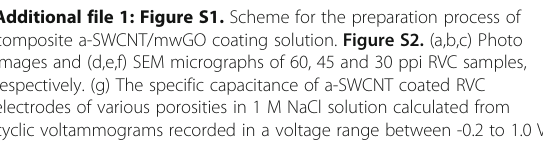
using a three-electrode system vs Ag/AgCl at 5mV/s scan rate. Figure S3. Schematic diagram of the preparation process of ratio 9:1 composite a- SWCNT/mwGO coated RVC electrode. Figure S4. (a and b) Energy- dispersive X-ray (EDX) spectra, (c) the XRD patterns of the graphite flakes powder and GO film respectively, and (d) Fourier-Transform Infrared (FT-IR) spectrum for graphene oxide film. Inset shows SEM and optical images of the (a) graphite flakes powder and (b) the GO film. Figure S5. (a and b) SEM images of GO and mwGO, respectively, (c) the XRD patterns of GO and mwGO and (d and e) Energy-dispersive X-ray (EDX) spectrum of GO film and microwave irradiated graphene oxide. Inset shows optical images of the (d) GO film and (e) mwGO. Figure S6. Raman spectroscopy of flake graphite, GO and mwGO. Figure S7. XPS spectra: comparison of the C1s spectra for (a) GO and (b) microwave irradiated graphene oxide (mwGO). Figure S8. Thermogravimetric analysis (TGA) of graphite flakes, GO, and microwave irradiated graphene oxide. Figure S9. (a) Visible absorption spectra vs wavelength of 0.1% w/ v mwGO dispersion, where inset photographs are for 0.1% w/v mwGO before sonication and after 35 minutes sonication, and (b) Absorbance at 660 nm vs sonication time. Arrow in (a) is indicating the direction of increasing sonication time. (c) Sonication energy vs absorbance at 660 nm for 0.1 % w/v mwGO dispersions.